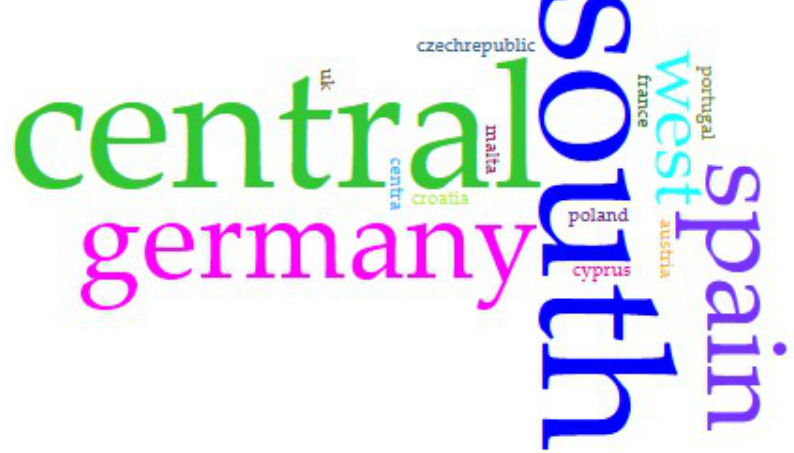
Figure 2. European Journeys by Benedict XVI (own figure, copyright by the author).